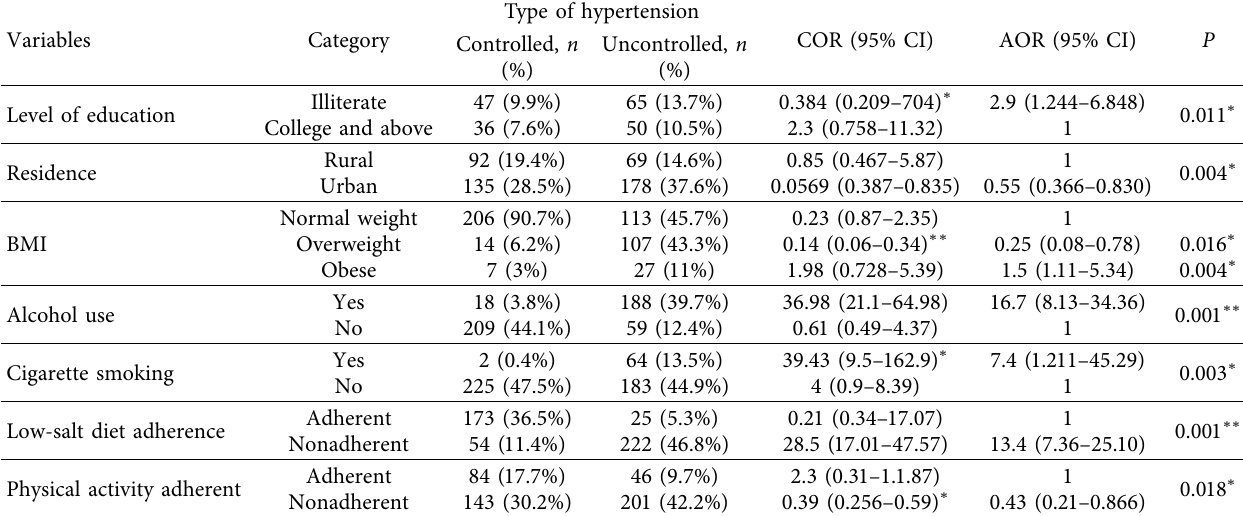
Table 4: Factors associated with uncontrolled hypertension among hypertensive patients attending St. Paul’s Hospital, Millennium Medical College, Addis Ababa, Ethiopia, 2020 ( n �